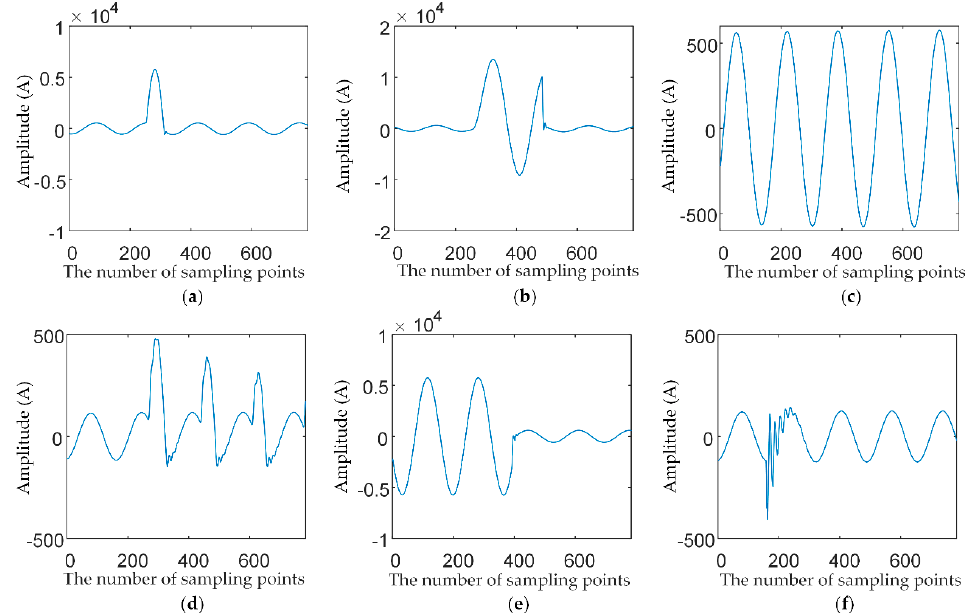
Figure 5. Current waveforms of incipient cable failure, normal signal and overcurrent interference: ( a ) Subcycle incipient cable failure ( b ) Multicycle incipient cable failure ( c ) Normal signal ( d ) Transformer inrush disturbance ( e ) Constant impedance failure ( f ) Capacitor switching disturbance.